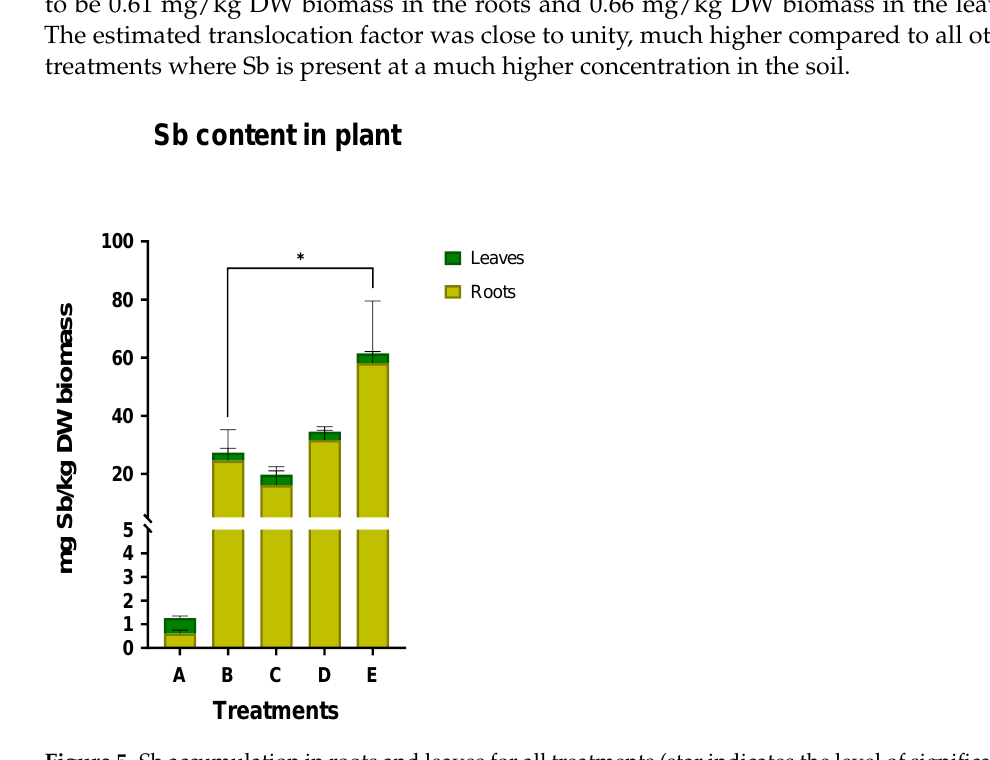
Figure 5. Sb accumulation in roots and leaves for all treatments (star indicates the level of significance: * for p < 0.05).